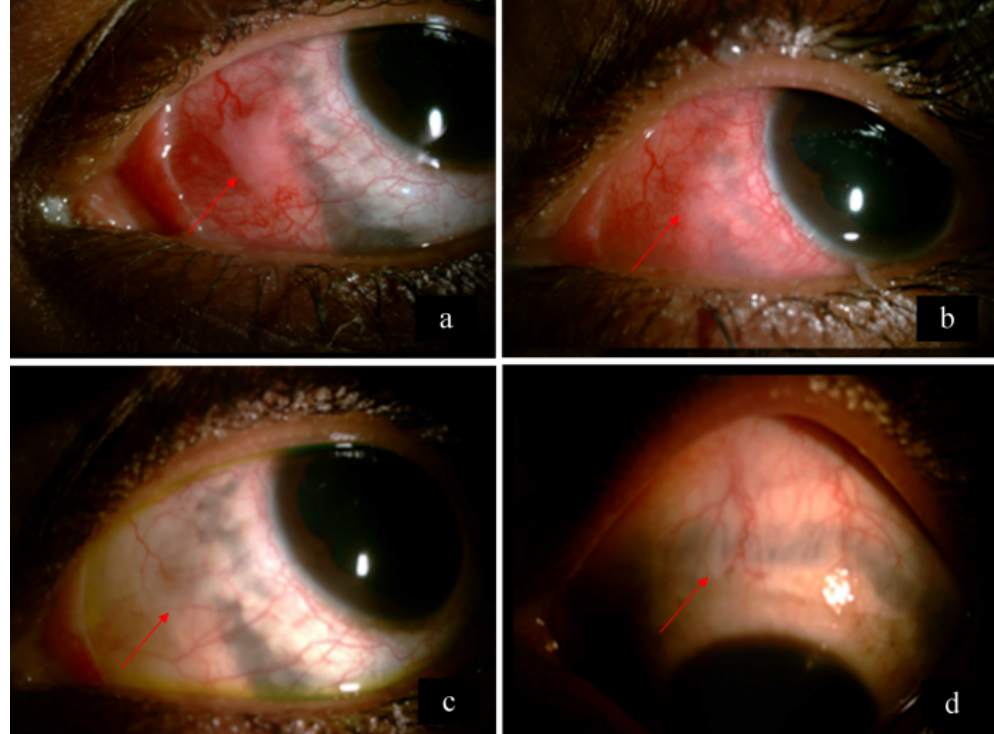
Figure 4: a) The left eye showing scleral abscess in the nasal quadrant with increased inflammation on 1 week follow-up after starting steroids (arrow). b) The scleral abscess is resolving on 2 weeks follow-up after stopping steroids (arrow). c) Complete resolution of the lesion (arrow) and d) scleral thinning is noted on 6 months follow-up